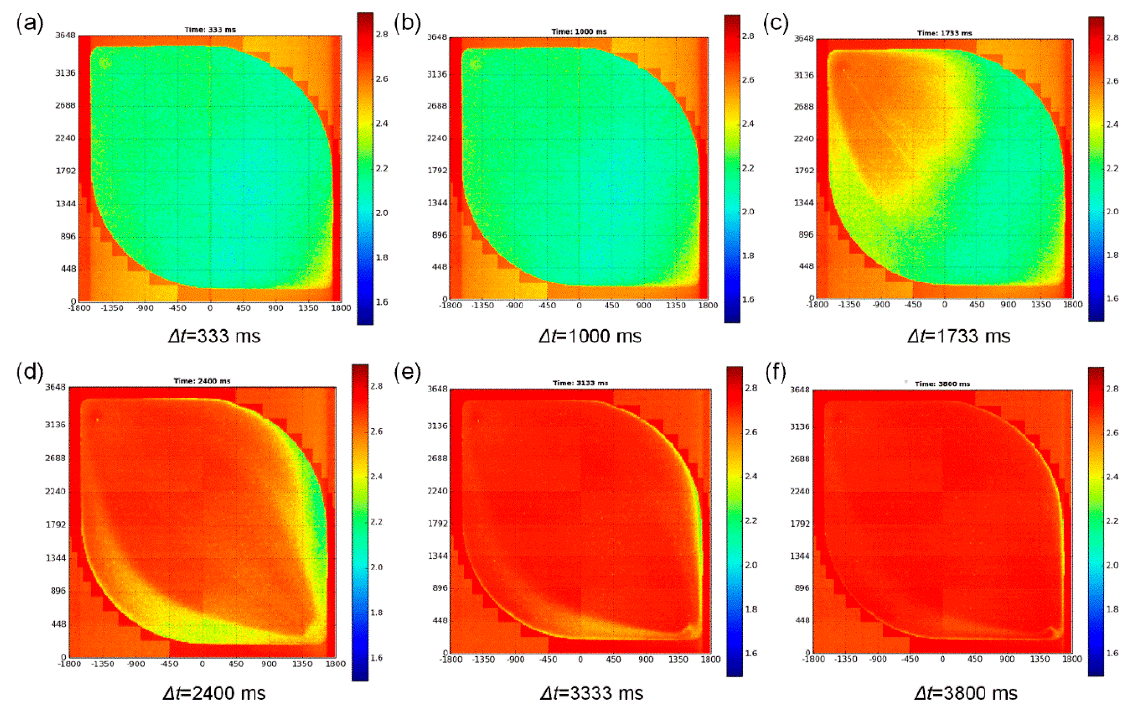
Figure 8. Maps of the sensor chip. The microfluidic system can precisely control the flow of the electrolyte solution on the chip surface; the signal processing and acquisition system can collect every pixel of the sensor array chip in real-time. The output of each pixel of the sensor array chip at a different time: ( a ) ∆ t = 333 ms. ( b ) ∆ t = 1000 ms. ( c ) ∆ t = 1733 ms. ( d ) ∆ t = 2400 ms. ( e ) ∆ t = 3333 ms. ( f ) ∆ t = 3800 ms.